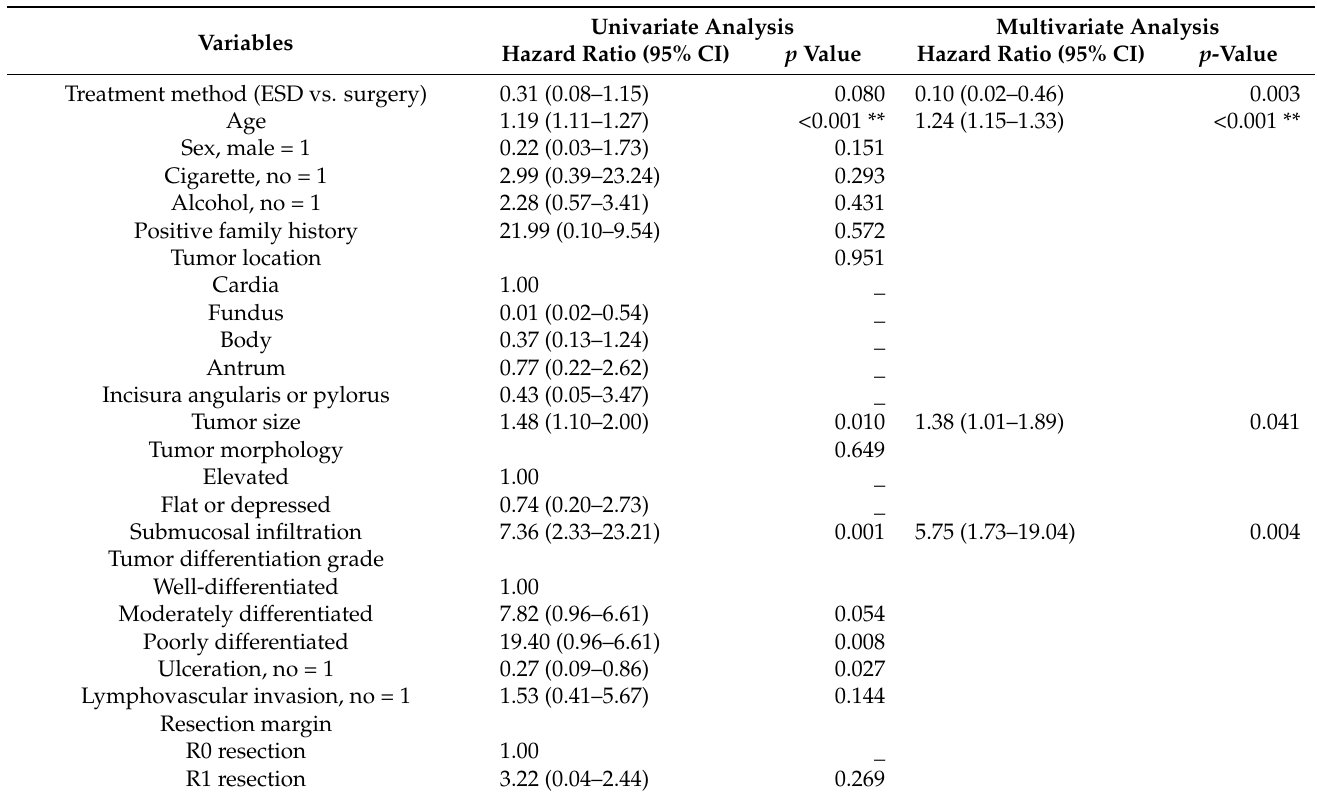
Table 7. Univariate and multivariate regression analyses of disease-specific survival for propensity score-matching